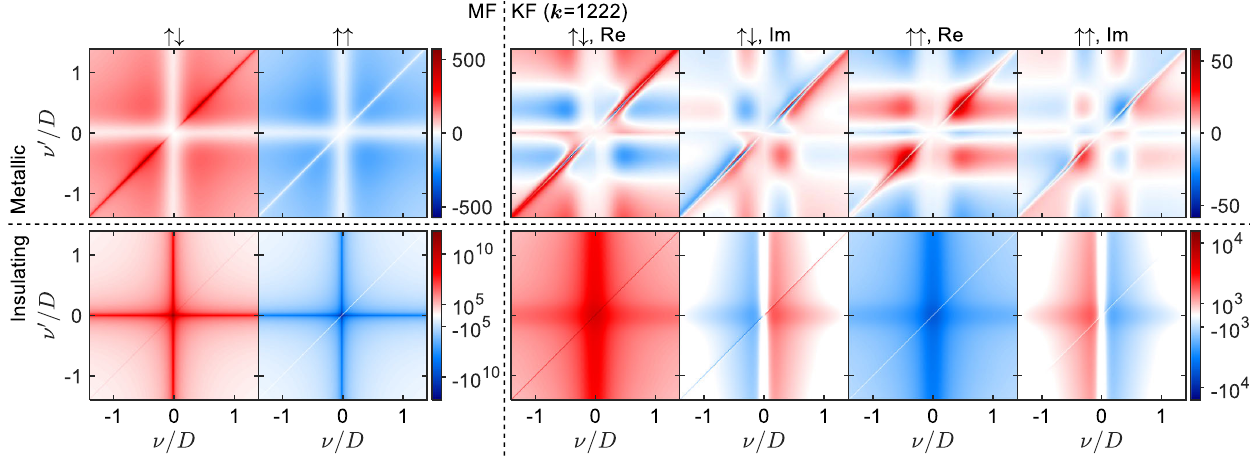
1 (cid:3) − F ½ 1 (cid:3) =U , respectively, at ω ¼ 0 in the DMFT solutions of σσ 0 0; σσ 0 Þ ω Þ has dips separating quasiparticle peak and Hubbard std ð